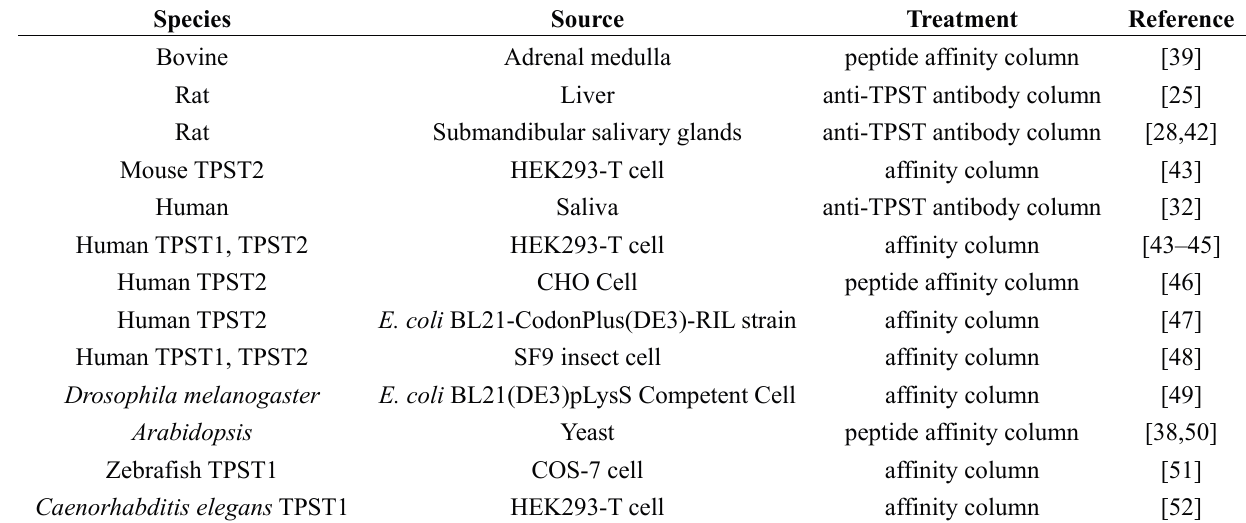
Table 1. Purification of tyrosylprotein sulfotransferase (TPST) a .